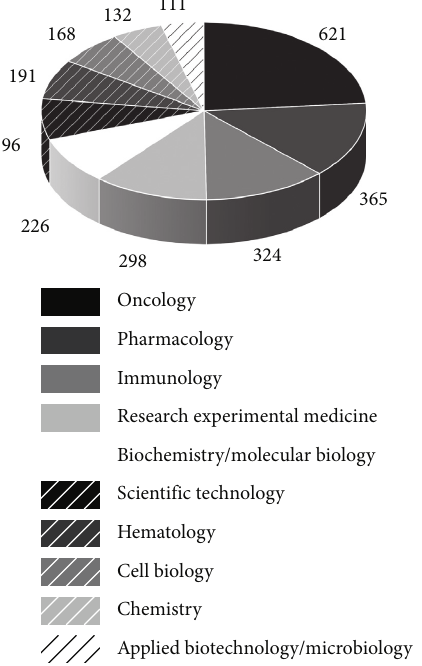
Figure 14: Main research areas of the scientific articles